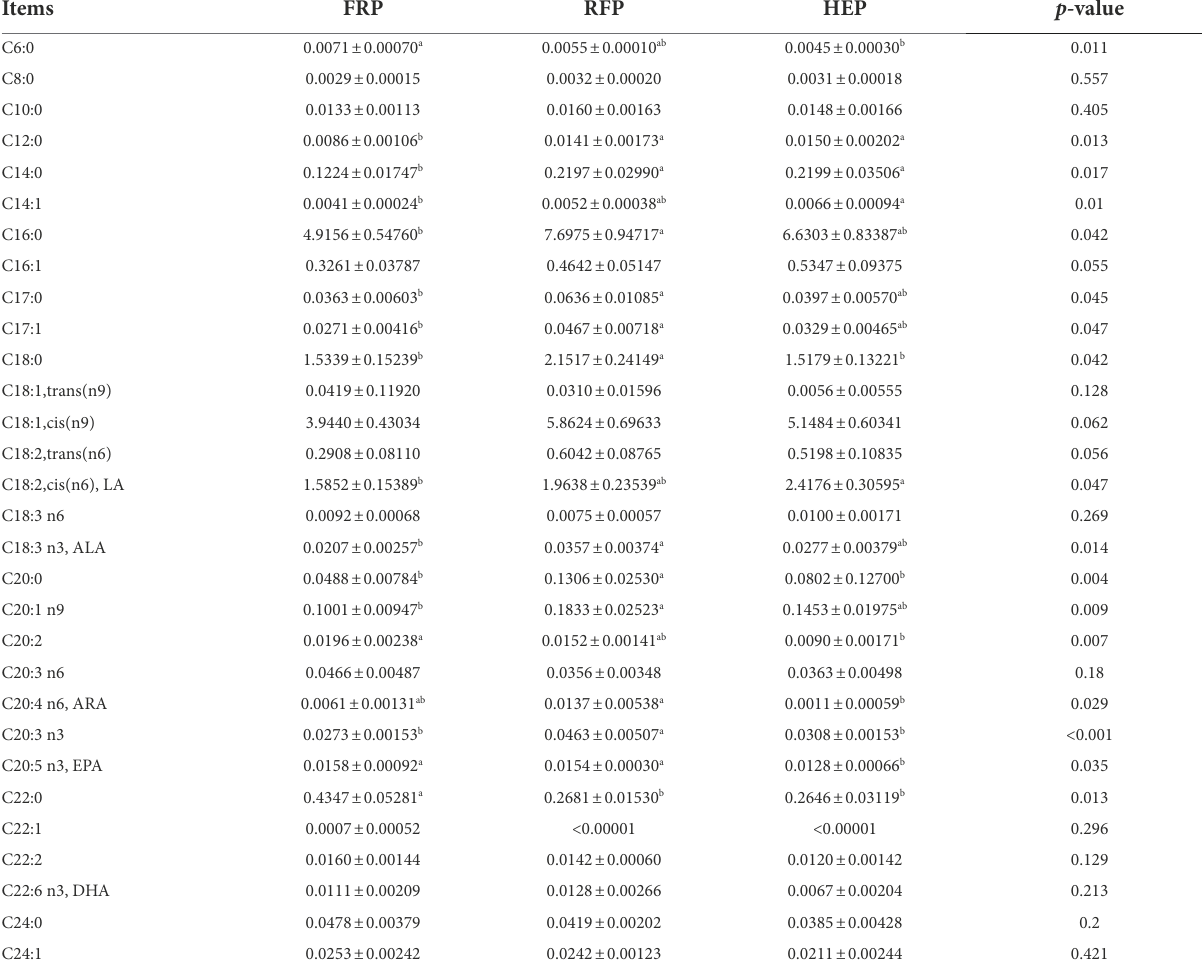
TABLE 3 The concentrations of free fatty acids in semitendinosus muscle.